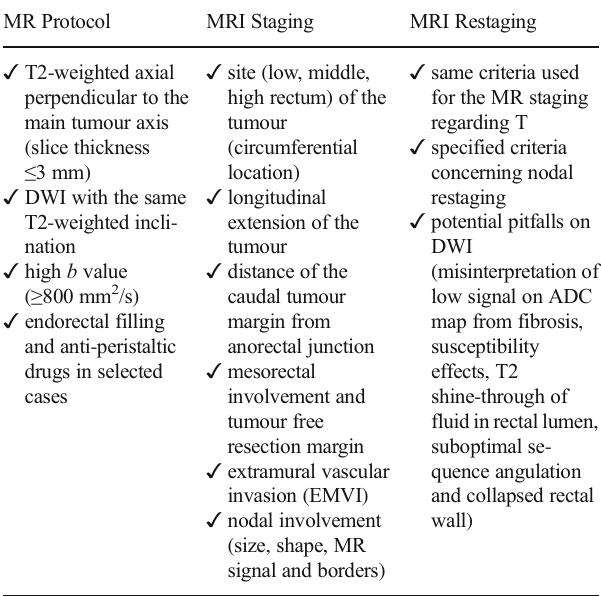
MRI protocol and diagnostic elements for rectal cancer that radiologists should consider in their clinical activity and report MR